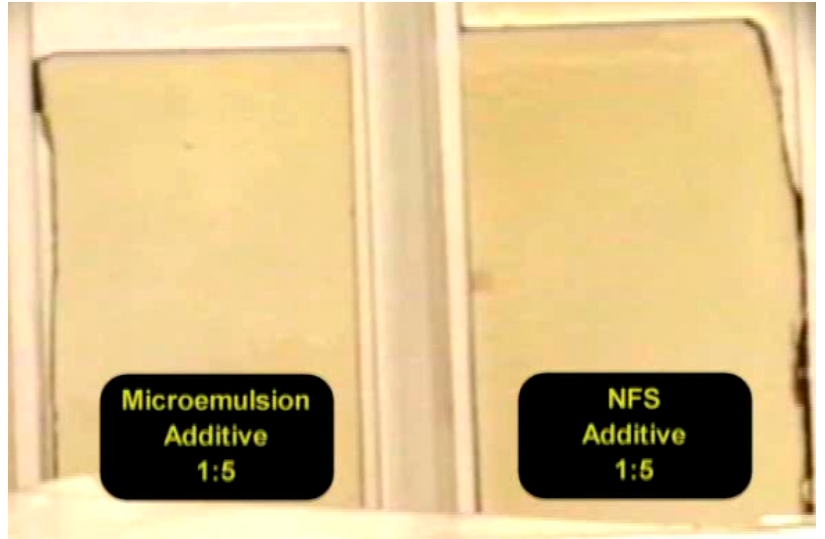
Figure 11. Parallel tests comparing the microemulsion additive and nanofluid additive in displacing oil from the 2D glass pores.